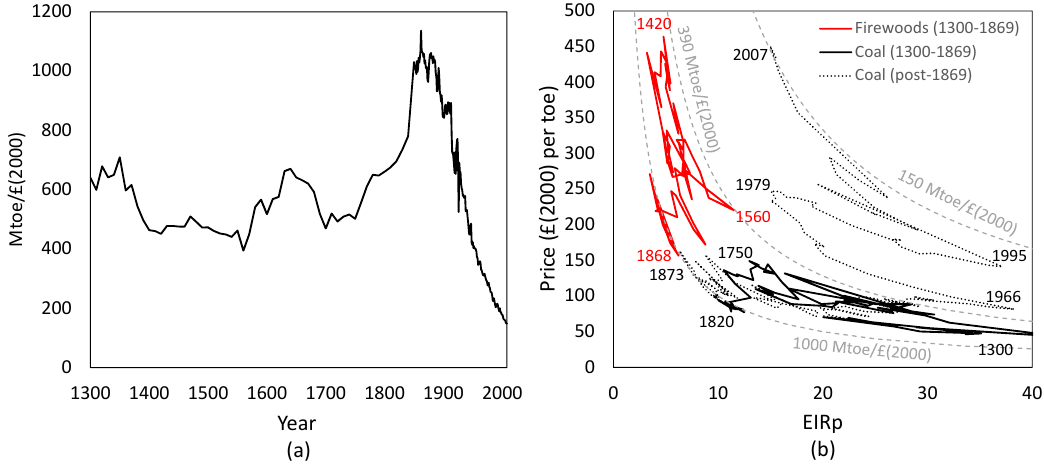
Figure 9. ( a ) England’s/the U.K.’s economy energy intensity; ( b ) price vs . EIR p for coal (average) and firewood for England and the United Kingdom from 1300 to 2008. Three example inverse curves show the constant energy intensity of England’s/the U.K.’s economy at 390,1000 and 150 Mtoe/£2000 in the years 1560, 1870 and 2008, respectively. Data from Fouquet